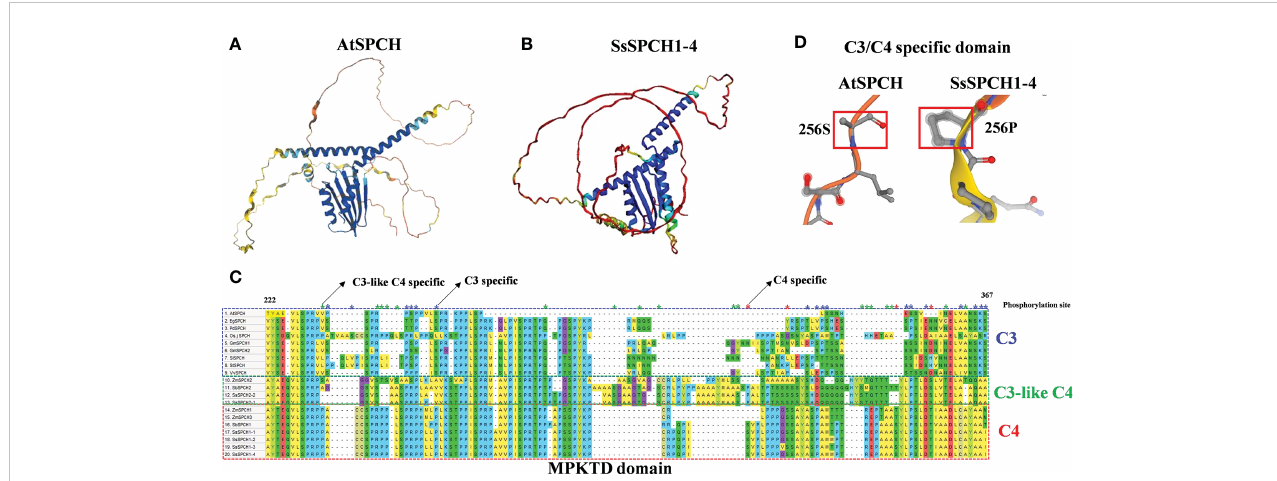
FIGURE 5 The 3D protein structure of (A) Arabidopsis SPCH and (B) Sugarcane SPCH1-4; (C) The alignment of MPKTD domains of C3 and C4 plants. The blue, red and green frame indicate the MPKTD sequence of C3, C4 and C3-like C4 SPCH. The blue, red and green asterisks indicate the C3-, C4, and C3-like C4- speci fi c phosphorylation sites (S/T) within the MPKTD domain; (D) The C3/C4 speci fi c S/T site (256) of AtSPCH and SssSPCH1-4.